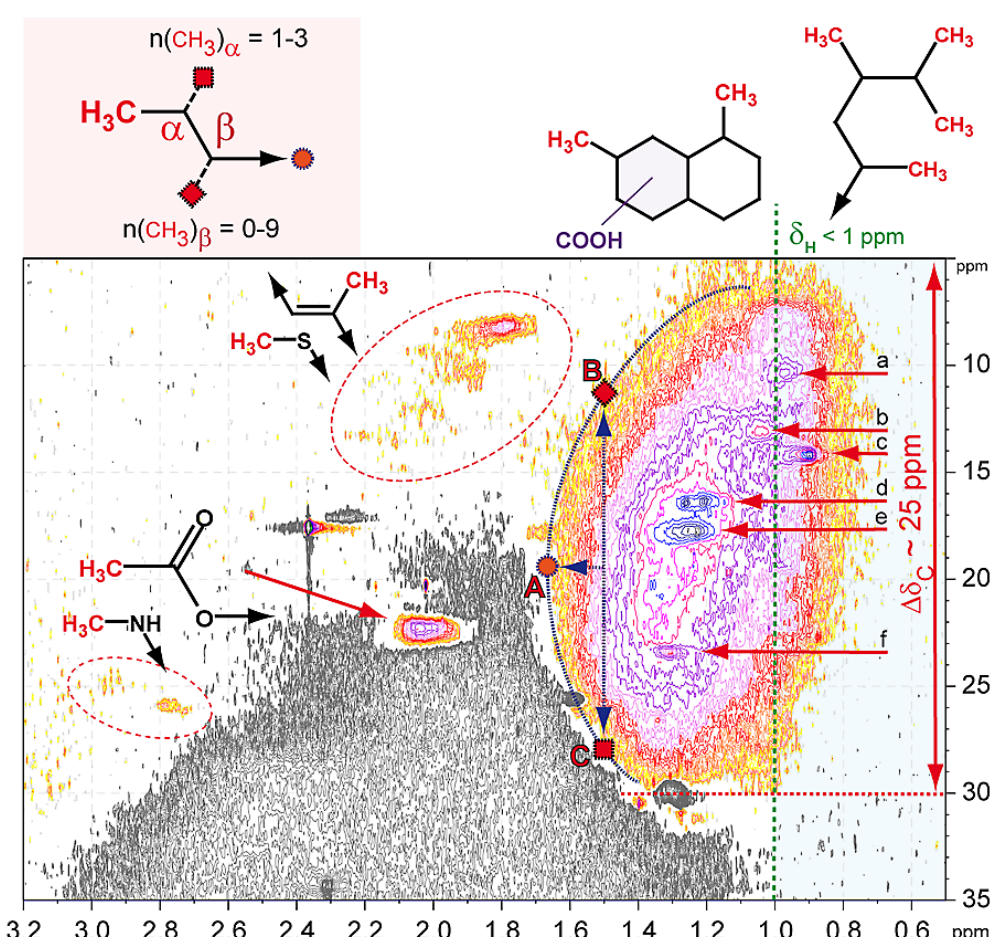
Fig. 8a. DEPT-HSQC NMR spectra of surface marine SPE-DOM at 5m. Section of H 3 C -C cross peaks with fundamental substructures indicated; blue: the proton chemical shift range ( δ H ≤ 1ppm) corresponding to classical methyl-terminating purely aliphatic units (e.g. peptide side chains) contributed only < 15% of total DEPT-HSQC methyl cross-peak integral (in all four SPE-DOM). The sizable expansion of carbon chemical shift for H 3 C -C units ( 1δ C : 5–30ppm) indicated near maximum diversity of remote aliphatic substitution, i.e. maximum diversity of aliphatic branching occurred in all four marine SPE-DOM (cf. Fig. 7). The six recognizable intensity maxima of aliphatic methyl (denoted: a–f) likely reflected superposition of remotely substituted common geometries of aliphatic branching. The bulk of aliphatic methyl experienced downfield shift from the chemical shift anisotropy of nearby carbonyl derivatives COX, most likely carboxylic groups, causing downfield proton chemical shifts up to δ H ∼ 1.6ppm. The depiction of aliphatic branching in 1 H and 13 CNMR spectra differs considerably: a relative insensitivity of 1 HNMR chemical shift with respect to aliphatic branching (negligible aliphatic substituent effects on 1 HNMR chemical shift beyond directly bonded carbon) contrasts with sizable aliphatic increments in 13 CNMR chemical shifts (substituent 13 CNMR chemical shift increments for carbon substitution C α : +9.1ppm; C β : +9.4ppm; C γ : − 2.5ppm; C δ : 0.3ppm; Kalinowski, et al., 1984), resulting in strong 13 C NMR chemical shift effects of aliphatic substitution at least up to two bonds away in any direction. The positioning of the H 3 C -C cross peaks results from three main operating effects: alkyl substitution in α -position (H 3 C-C α -; three different options) causes increased carbon chemical shift (arrow pointing toward C); alkyl substitution in β -position (H 3 C-C-C β -; ten different options) causes decreased carbon chemical shift (arrow pointing toward B). Proximate carbonyl derivatives COX (likely carboxylic groups) cause downfield proton chemical shift (arrow pointing toward A). The smooth curvature of the boundary line indicates near-statistical distribution of respective chemical environments A, B, and C. Alicyclic aliphatic geometry (Cho et al., 2011) favours large abundance of proximate COX with respect to given counts of methyl groups, supporting the occurrence of CRAM (carboxyl-rich alicyclic molecules) as abundant contributors to marine SPE-DOM (Hertkorn et al., 2006; Lam et al., 2007; Leenheer et al., 2003). Methyl groups attached to olefins were common; minor suites of S- CH 3 groups might also have occurred in this cross-peak section. Acetate derivatives and a few minor N- CH 3 groups complemented the major H 3 C -C chemical environments